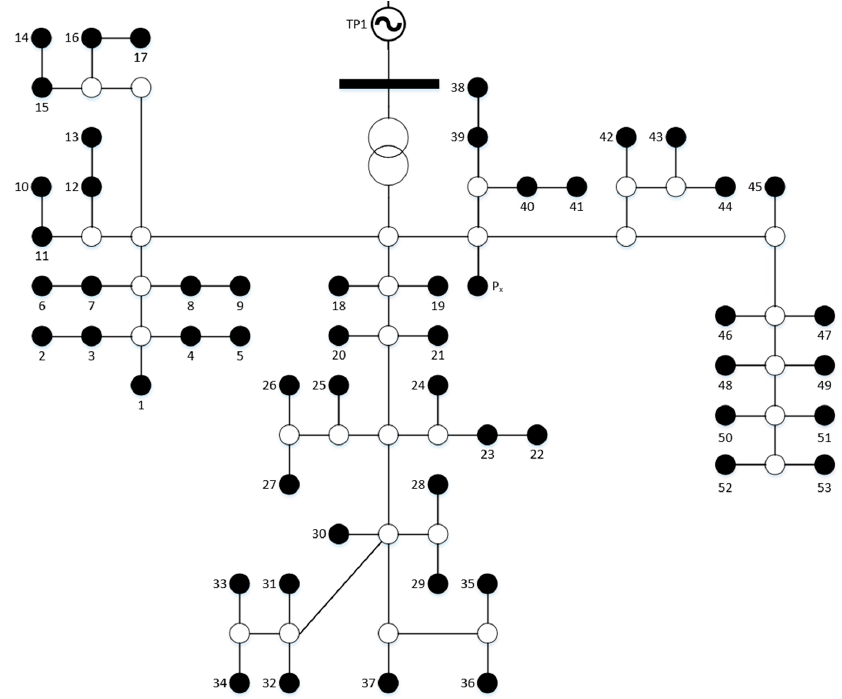
Figure 4. Topology of the LEC power system used in the case study.